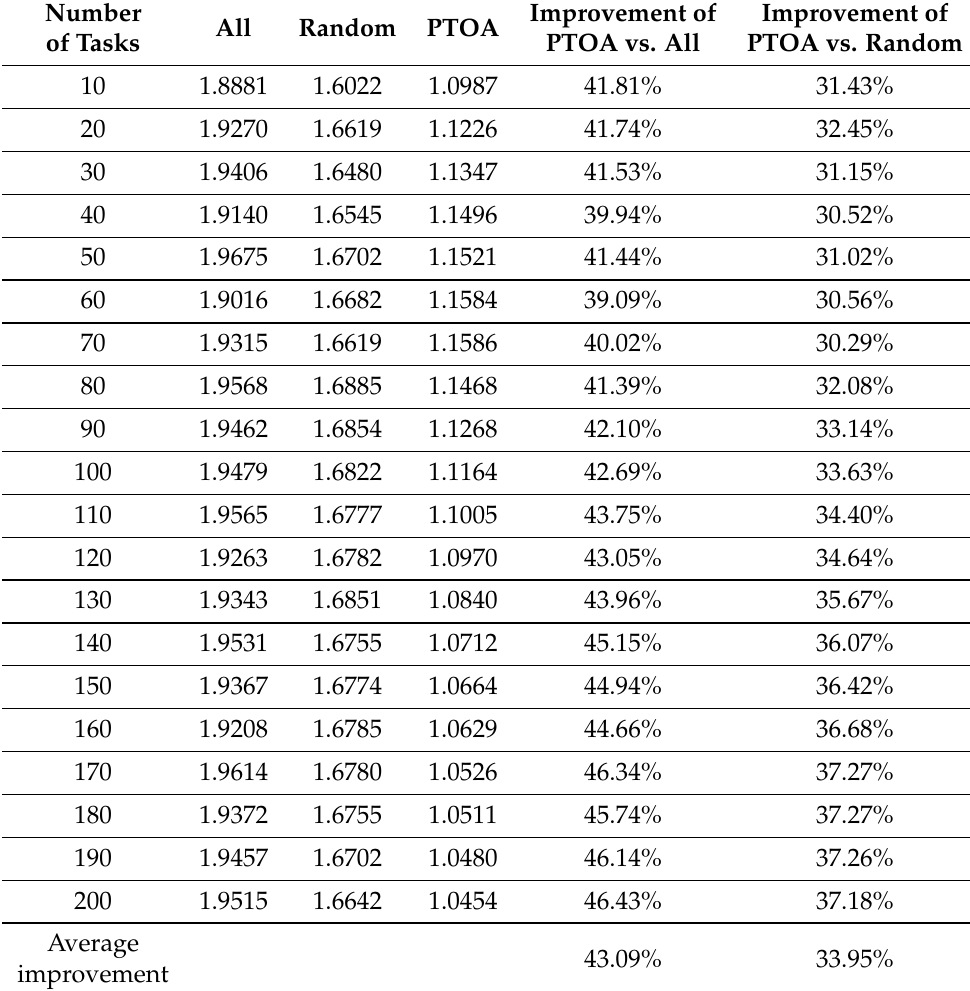
Table 2. Comparison of the location privacy-preserving ability of PTOA with the methods All and Random with different numbers of